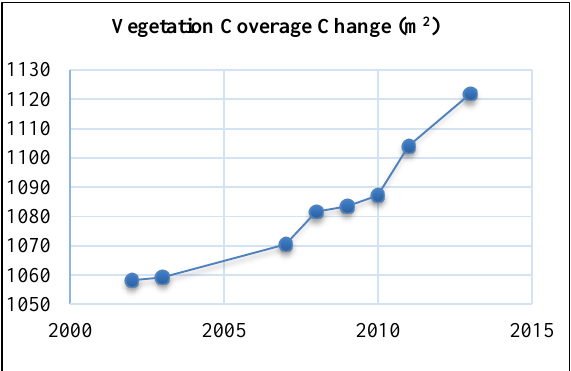
Figure 6. the Typical Island and Sandbar Vegetation Change